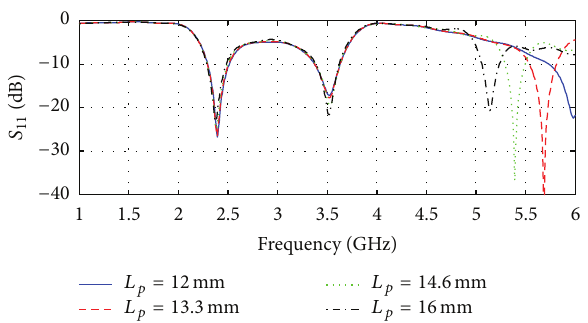
Figure 6: Simulated return loss with different 𝐿 𝑝 .